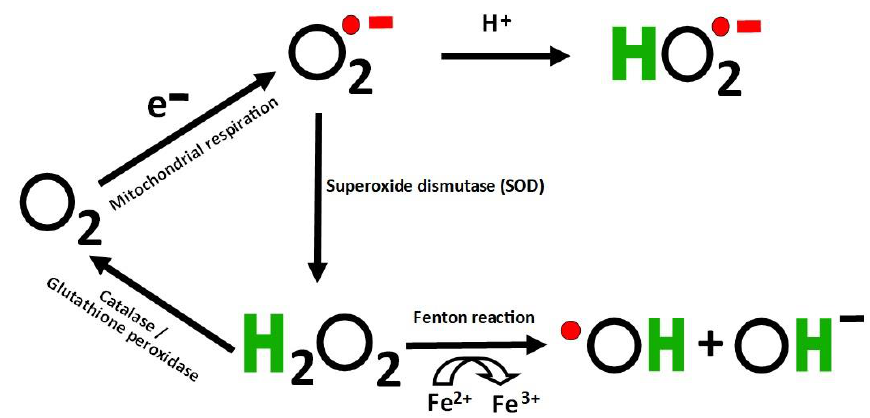
Figure 2. ROS generation. The superoxide is generated from oxygen in the mitochondrial respiration chain, which can be further converted into hydrogen peroxide via superoxide dismutase. The hydrogen peroxide can be transformed to hydroxyl radicals and hydroxyl anions.